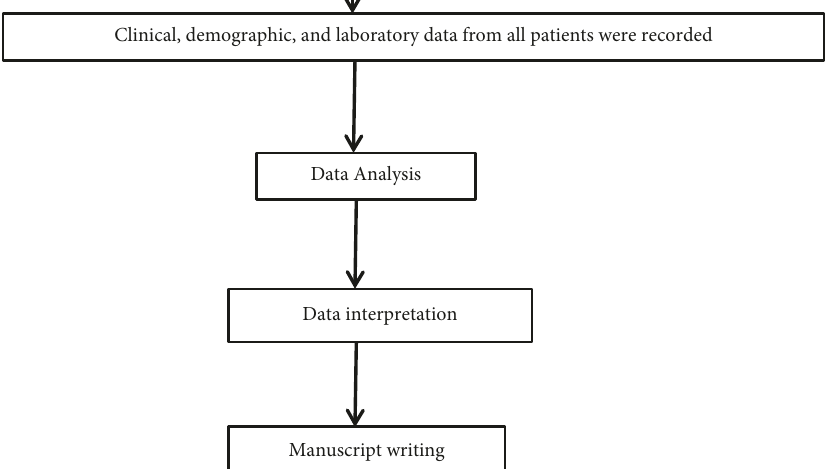
Figure 1: Flowchart of this present research